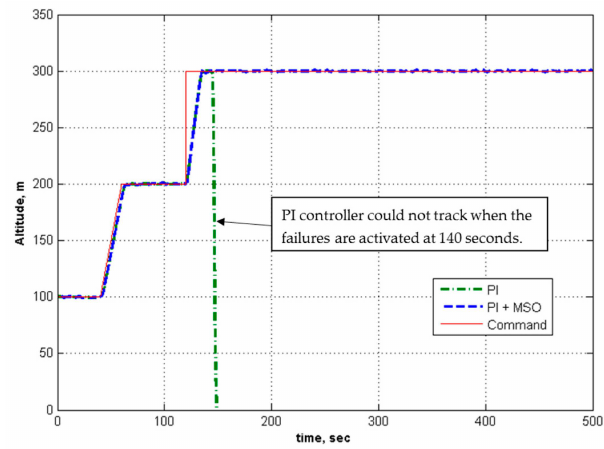
Figure 11. Altitude response for 50% C m α in aircraft ( C m α in an aircraft = 0.5 ˆ design C m α ).